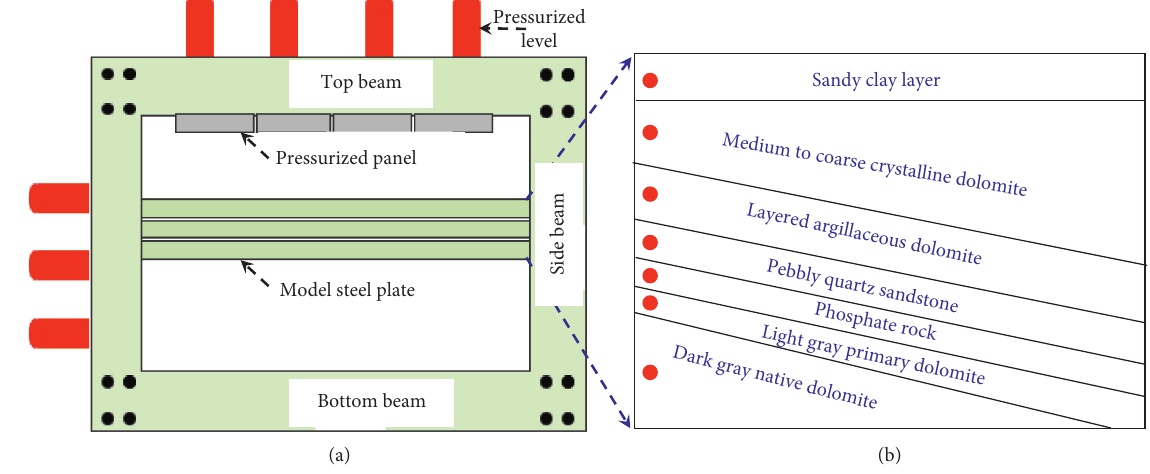
Figure 4: (a) Similar model; (b) similarity simulation experiment profile. Table 1: Rock mechanics parameters